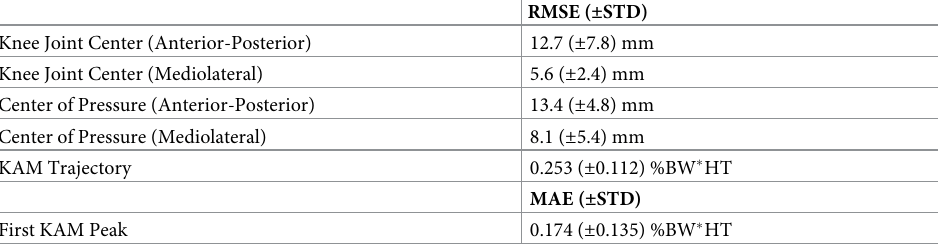
Table 2. Evaluation of the learned gait patterns against ground truth measurements in the Stanford University dataset.